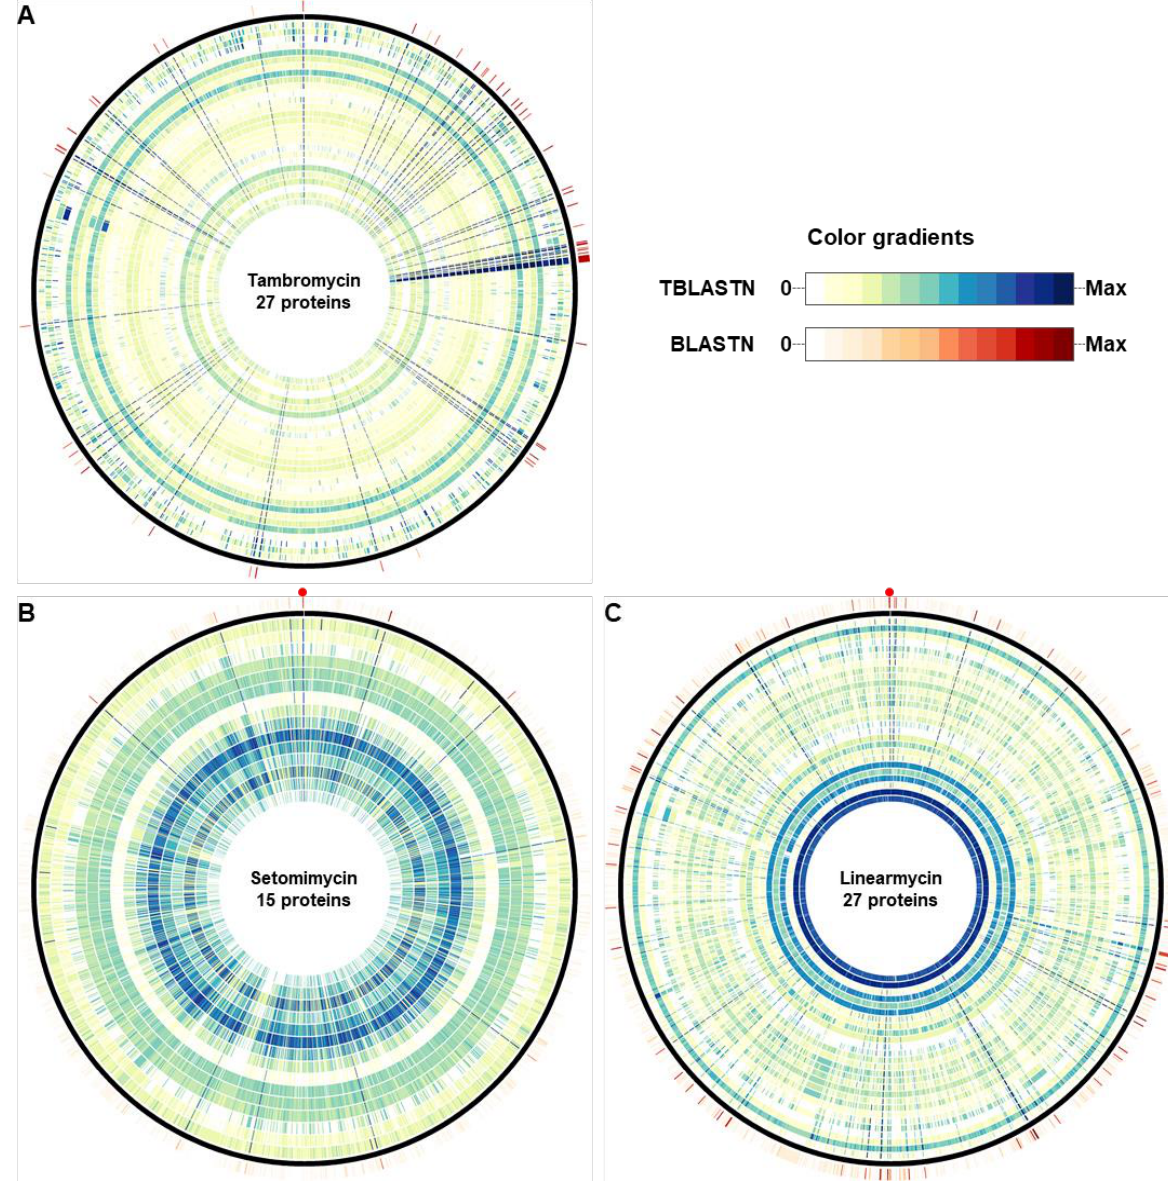
Figure 4. Distribution of proteins in gene clusters producing tambromycin ( A ), setomimycin ( B ), and linearmycin ( C ) in 2062 Streptomyces genome sequences. Protein sequences from each cluster were searched using TBLATN with an E-value cutoff of 1e −5 . The dark navy-blue color shows the maximum bit score for each protein. The track outside the ideogram shows the sum of bit scores from BLASTN searches when the nucleotide sequences of each cluster were used as the query, with an E-value cutoff of 1e −20 . The darker the color of a cell, the more homologous the corresponding sequence is. The strain JCM 3382 is marked by a red dot in each diagram.